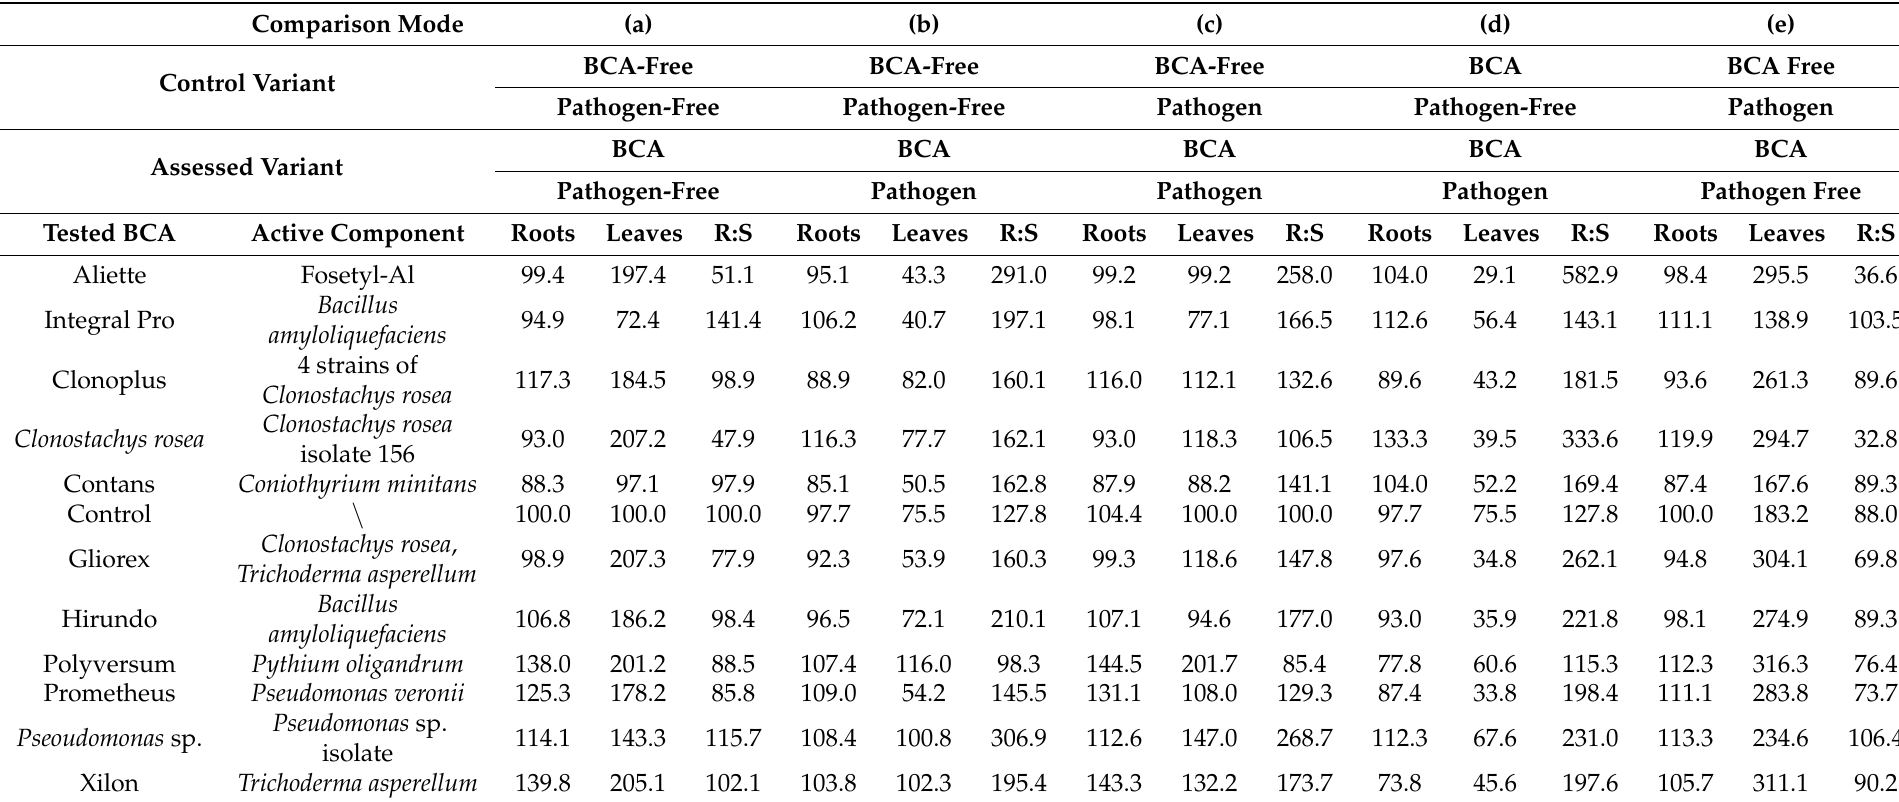
Table 5. The results of five comparisons of strawberry plants in different variants of combinations of the presence and absence of BCAs and P. cactorum . Comparison